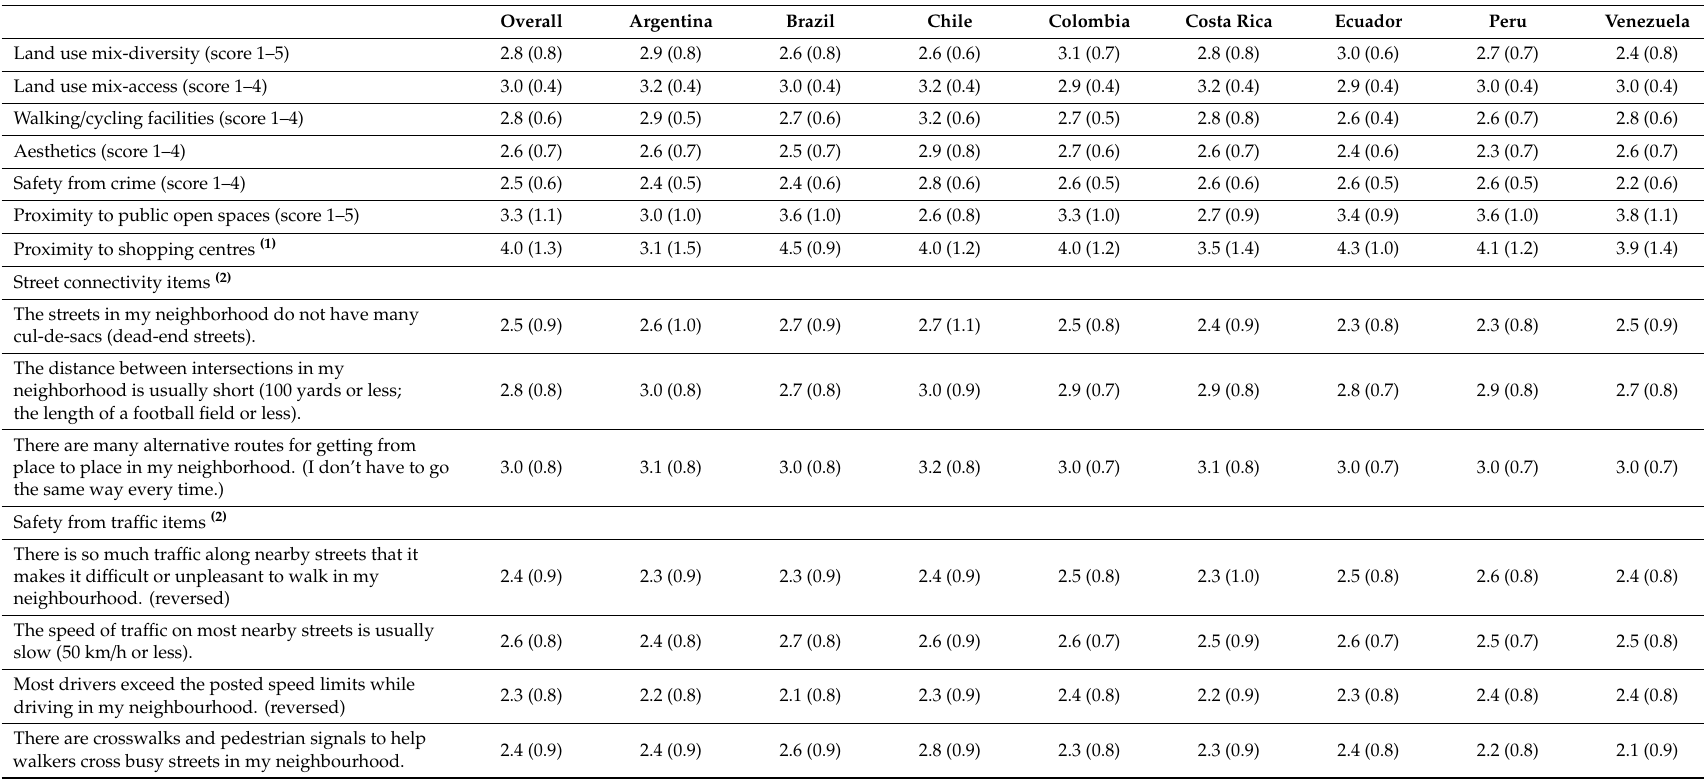
Table 3. Overall and country perceived-environment